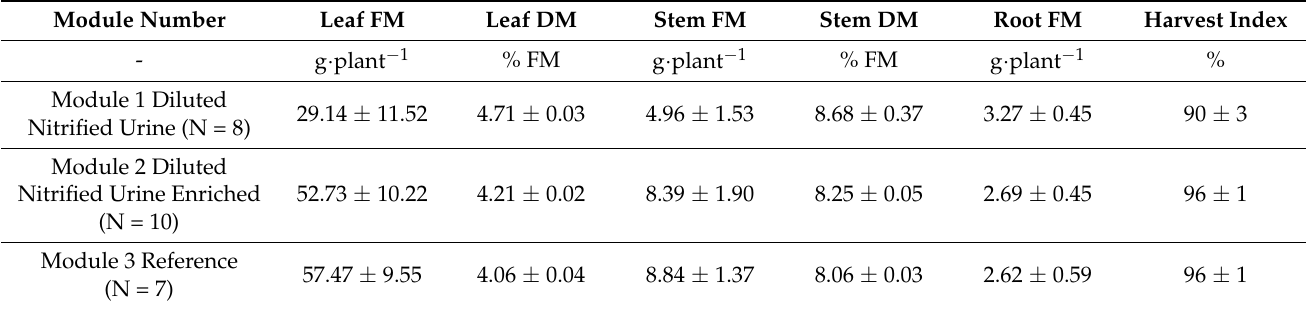
Table 3. The effect of different nutrient solutions on the lettuce yield (average ± SD). FM—fresh mass, DM—dry mass, N—number of lettucces.